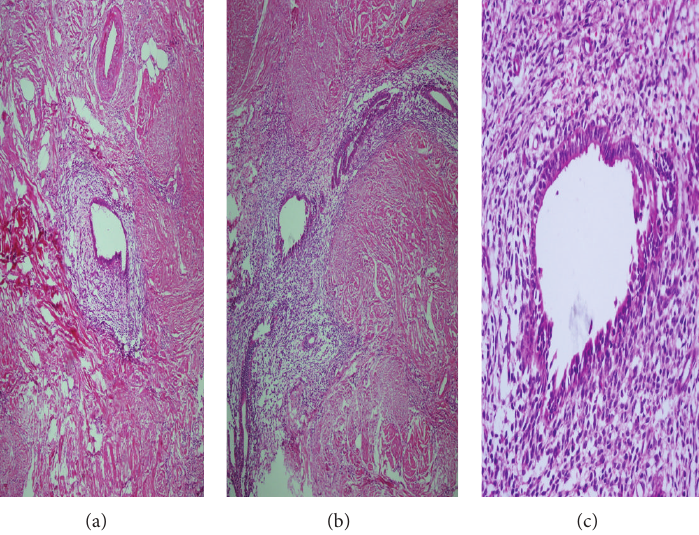
Figure 2: (a) Endometriotic glands and stroma in the subcutaneous tissue. ((b)-(c)) Dense chromatin nuclei with subnuclear vacuoles corresponding to early secretory phase. (Hematoxylineosin strain; original magnification: a, X20; b, X10; c,